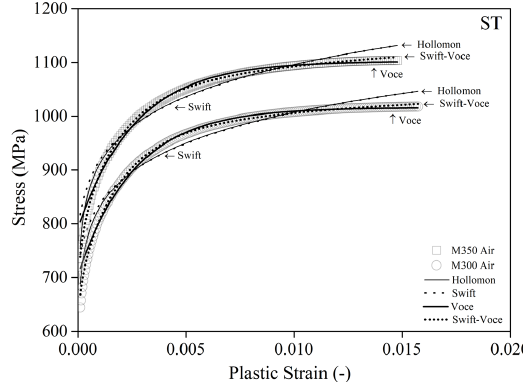
Figure 6. Curve fitting approach using different models for ST maraging steels by air environment.